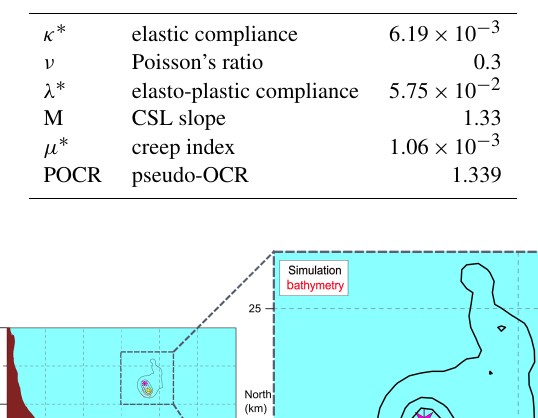
Table 1. VNM parameter values (post-calibration and dimension- less).